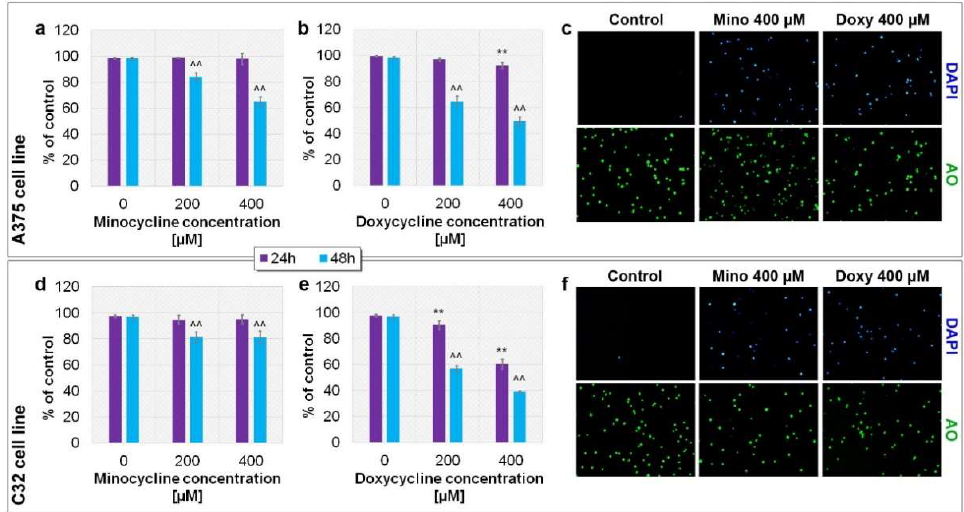
Figure 3. Analysis of melanoma cell viability after the treatment with minocycline and doxycycline. The results are expressed as a percentage of control. Bar graphs present the results for A375 ( a , b ) and C32 ( d , e ) cell lines. Representative images ( c , f ) show analyzed cells stained with acridine orange AO (all cells) and DAPI (dead cells). ** p < 0.005 vs. control 24 h; ^^ p < 0.005 vs. control 48 h.